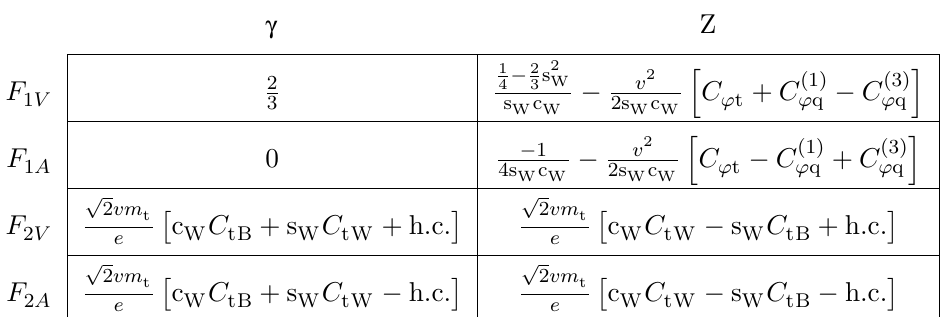
Table 4. The contributions to the top-quark photon and Z couplings induced by the operators in table 3. The sine and the cosine of the weak mixing angle are denoted s while v ’ 246 GeV is the Higgs (cid:12)eld vacuum expectation